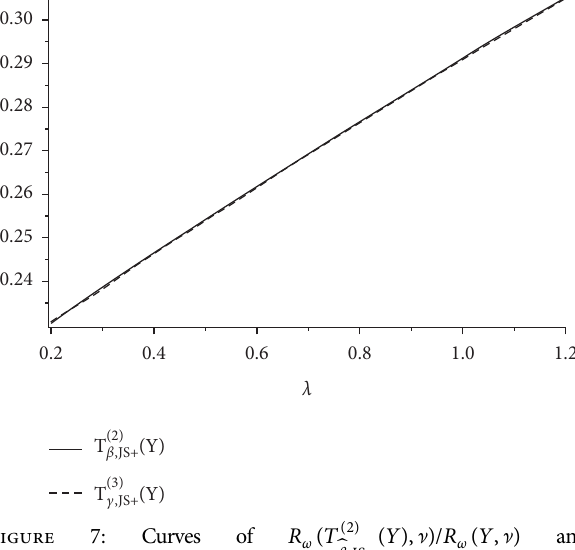
( Y, ] ) as functions of λ for d � 8 and ω � 0 . 1. ω